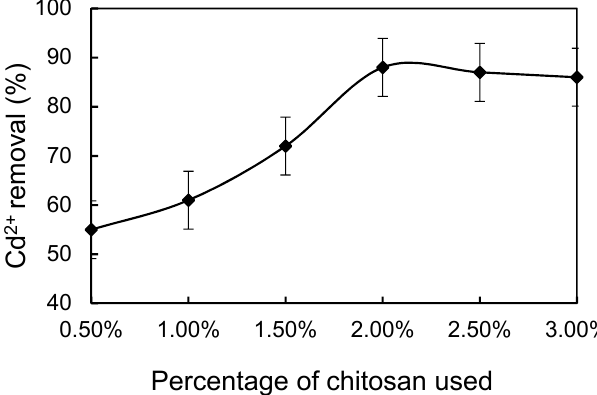
Figure 1. Effect of initial chitosan usage on Cd 2+ removal.